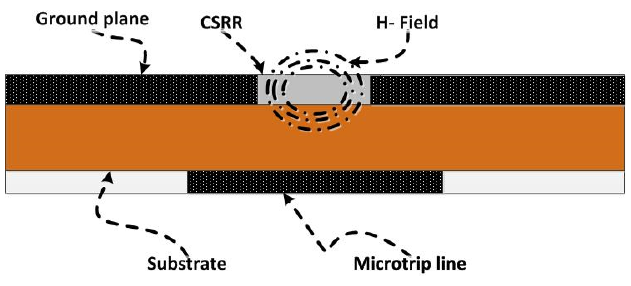
Figure 7. Magnetic field lines around the bridge line labeled A in Figure